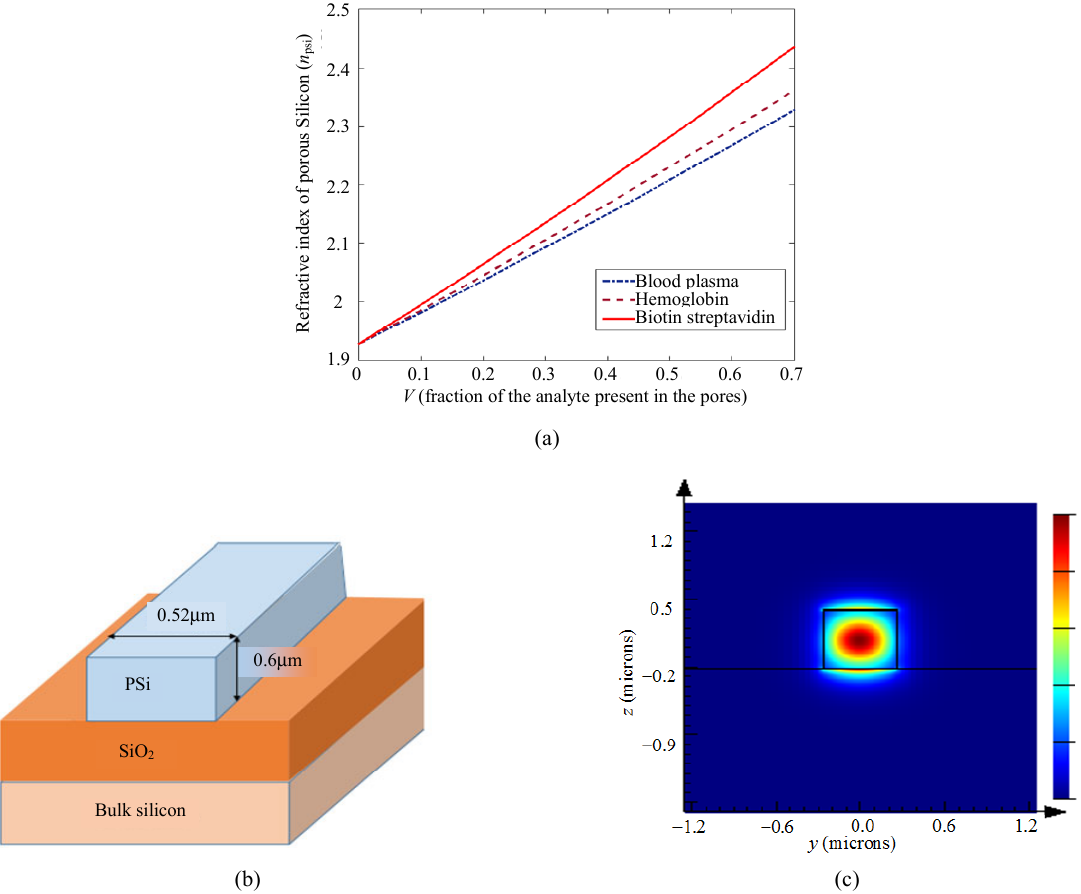
Fig. 1 Modal analysis of waveguide showing (a) variation in the refractive index of the PSi for p = 50% for a change in analyte fill fraction “ V ”, (b) crossectional view, and (c) mode confinement in the strip